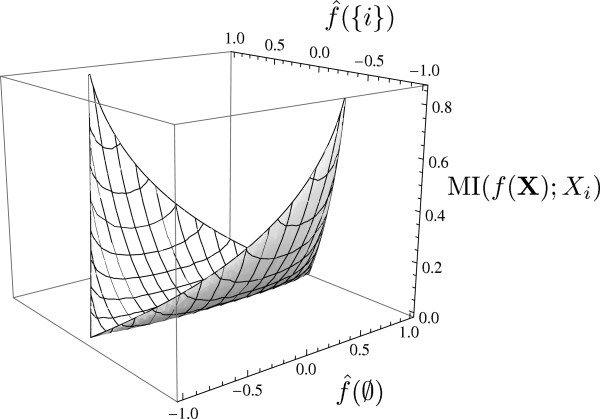
MI(f(X); Xi) as a function off^({i}) andf^(∅) forpi=0.3.